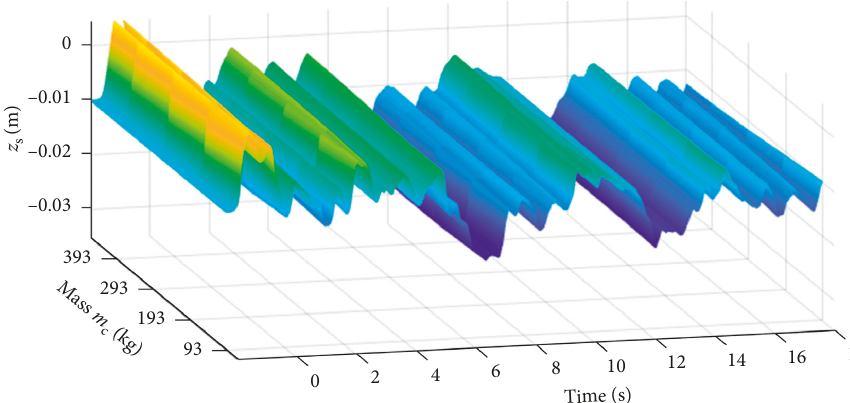
Figure 7: The variation of z